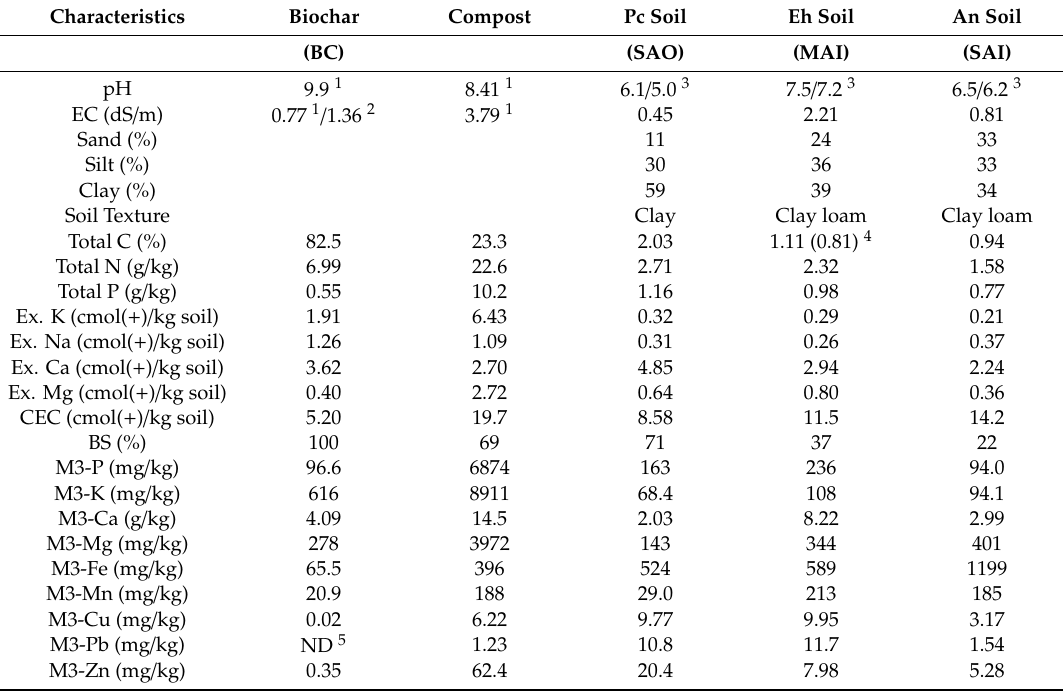
Table 1. Characteristics of biochar, compost, and three studied